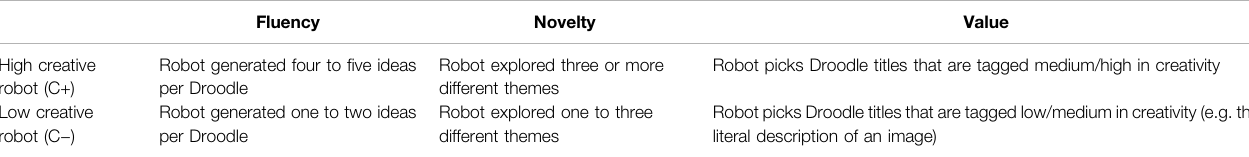
TABLE 1 | A gameplay comparison of the high creative and low creative study